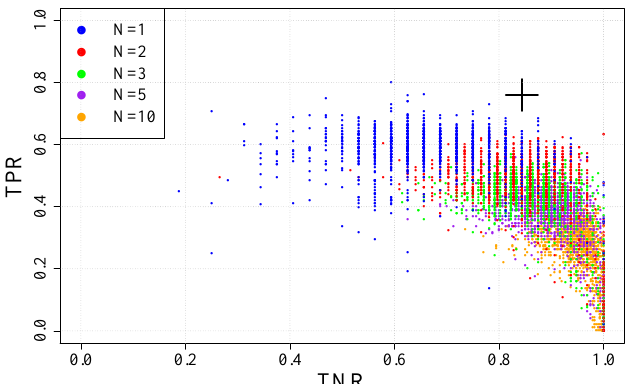
Figure 14. Neural network configurations.